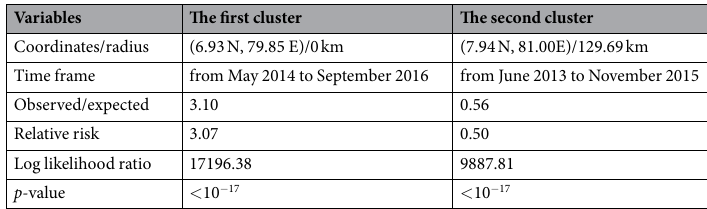
Table 4. The characteristics of each cluster. The first cluster includes Colombo, and the second cluster includes Ampara, Anuradhapura, Badulla, Batticaloa, Kurunegala, Kandy, Kegalle, Matale, Moneragala, Nuwara Eliya, Polonnarwa, Puttalam, Trincomalee, and